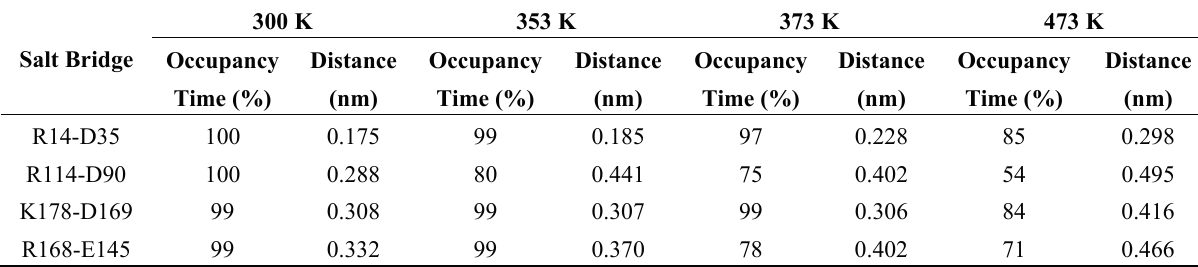
Table 6. Important salt bridge interactions of P186_1588 at 300K, 353K, 373K, and 473K simulation and their occupation time *.